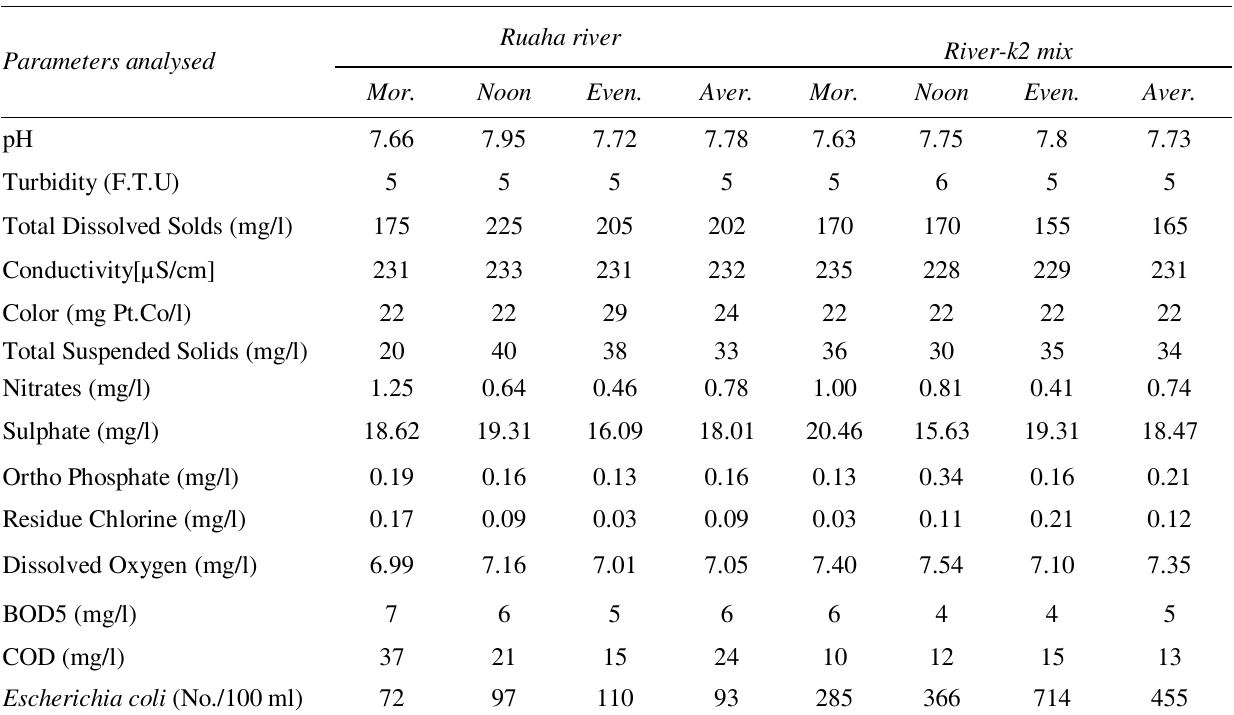
Table 4: Water quality from Ruaha river